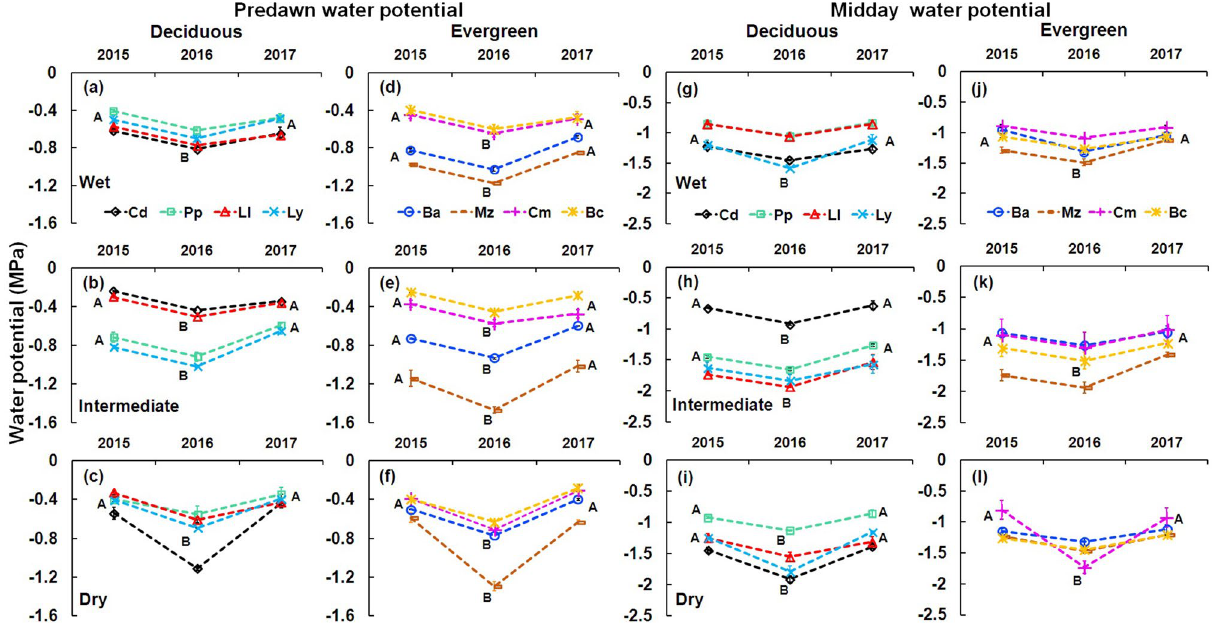
Figure 4. Predawn and Midday water potential for studied species in all sites from 2015 to 2017. Predawn water potential: panels are for deciduous species ( a – c ) and panels for evergreen species ( d – f ). Midday water potential: panels are for deciduous species ( g – i ) and for evergreen species ( j – l ). Deciduous species: Cordia dodecandra (Cd), Piscidia piscipula (Pp), Leucaena leucocephala (Ll), Lysiloma latisiliquum (Ly). Evergreen species: Brosimum alicastrum (Ba), Manilkara zapota (Mz), Chrysophyllum mexicanum (Cm), Byrsonima crassifolia (Bc). Data are means ± SE. Capital letters next to species indicate significant differences among